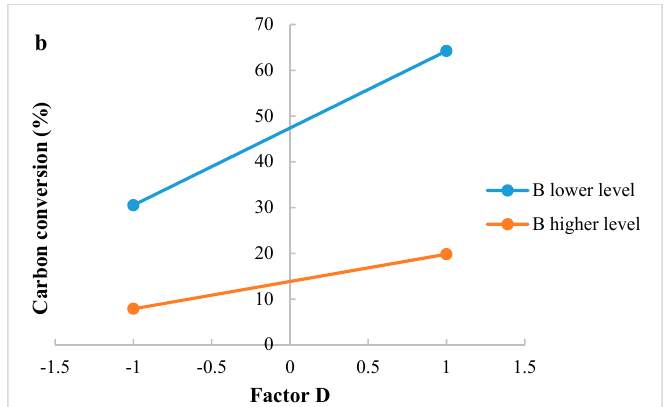
Figure 4. ( a ) Test of two levels for the analysis of interaction AC in carbon conversion; ( b ) Test of two levels for the analysis of interaction BD in carbon conversion. (A = CO composition in mol%, B = temperature in °C, C = recycle in %, D = water removal in %).